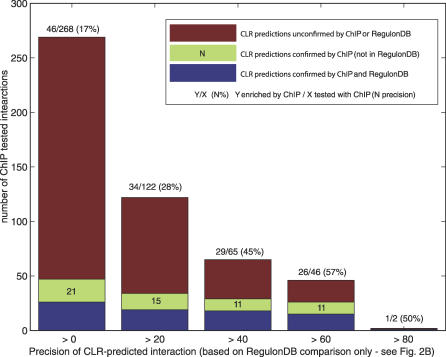
Experimental Validation of Inferred Regulatory InteractionsGlobal precision scores determined with RegulonDB for a set of 268 regulatory interactions were in good correspondence with the local precision scores determined via RegulonDB plus ChIP for three transcription factors. The blue bar indicates inferred interactions that are true positives based on RegulonDB and ChIP. The green bar shows the number of inferred interactions not in RegulonDB that were positive for ChIP, representing 21 new experimentally verified regulatory interactions. The red bar shows inferred interactions that are false positives based on RegulonDB and ChIP.